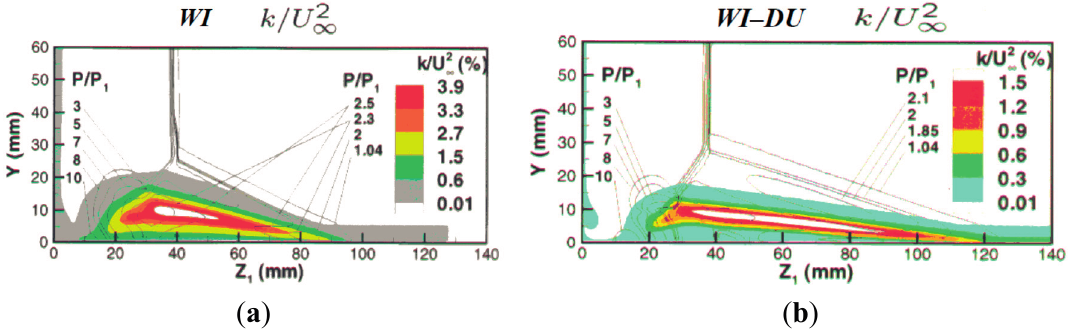
Figure 18. Turbulent kinetic energy in cross section ( x 1 = 122.5 mm): ( a ) The linear Wilcox’s k – ω -model (WI); ( b ) Weakly nonlinear k – ω - model (WI–DU). Reprinted [17]